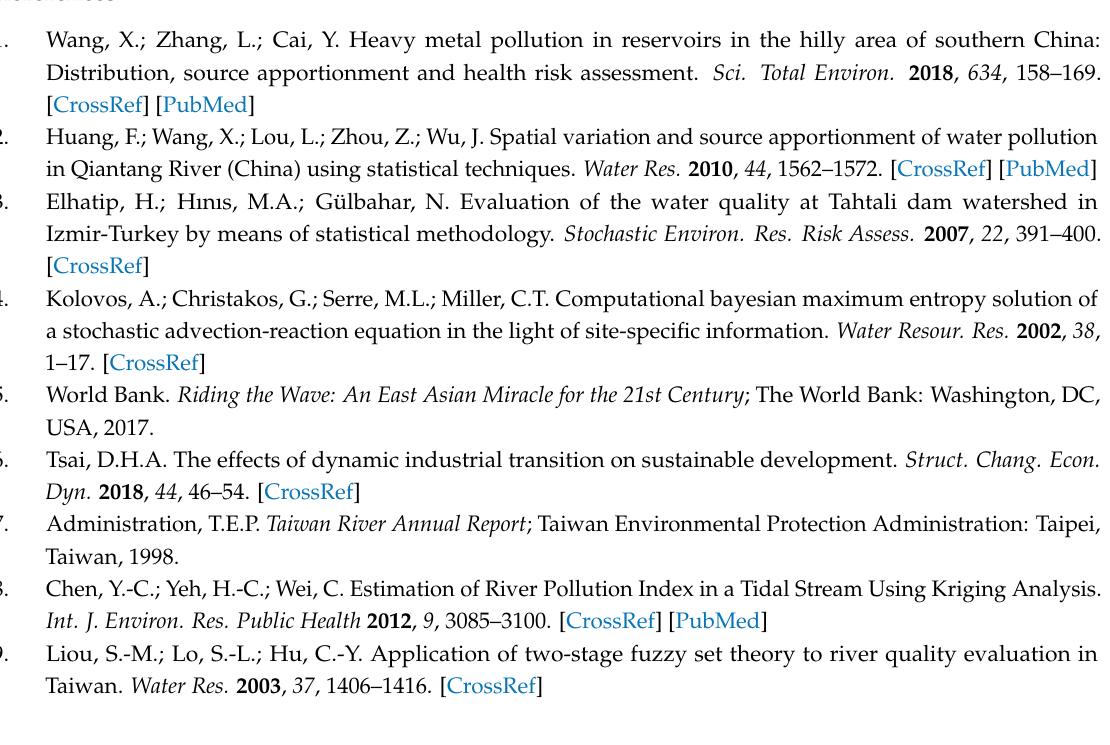
s1, Table S1: Water Quality and Heavy Metal Monitoring Methods, Table S2: Taiwan EPA water quality standards for heavy metal content in surface water, Table S3: River Pollution Index Descriptive Statistic Table, Figure S1: Laojie river map with industrial area and total population data; Figure S2: Heavy metal distribution in Laojie River (sampling locations S1-S7 are in order from upstream to